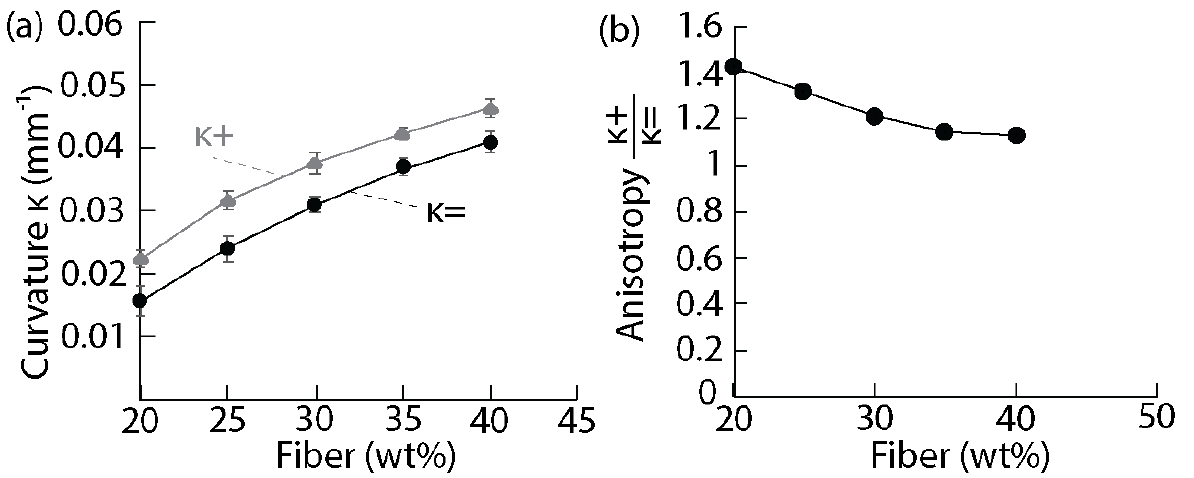
Figure 7. Curvatures and anisotropy in composite monolayers. ( a ) Curvatures κ = and κ + as a function of the fiber content in the composites measured after drying; ( b ) Anisotropy in the deformation κ + κ = after drying as a function of the fiber content.